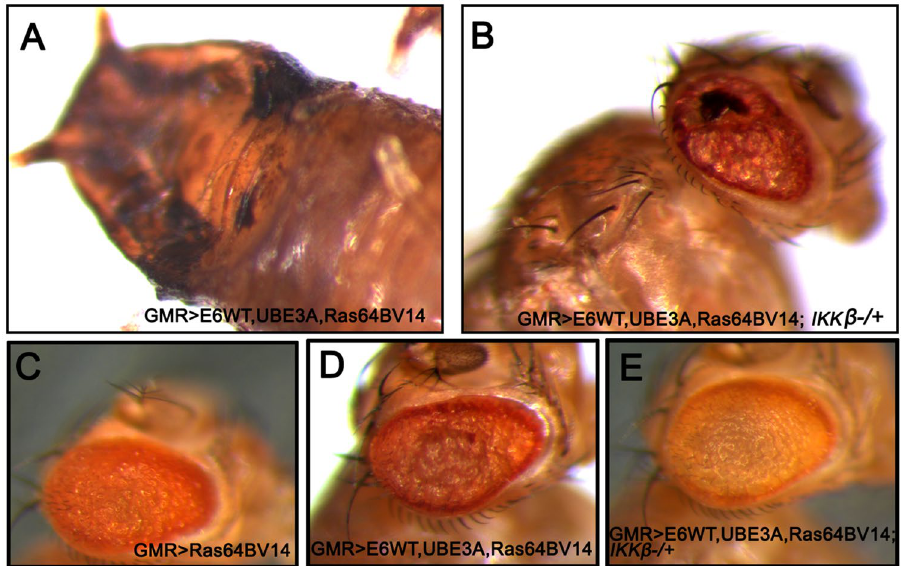
Figure 5. Reduction of IKKβ suppresses the cellular transformation caused by cooperative action of Ras and E6 + UBE3A. ( A , B ) Expression of transgenes at 25 °C. ( B ) A mutated copy of IKKβ gene in eyes expressing E6, UBE3A and an oncogenic Ras, suppresses pupal lethality and the severe defects caused by cooperative action of E6, UBE3A and oncogenic Ras ( A ). ( C – E ) Expression of transgenes at 22 °C. ( C ) Expression of oncogenic Ras in the eye causes cellular transformation. ( D ) Co-expression of E6 and UBE3A with oncogenic Ras enhances the Ras phenotype. ( E ) A mutated copy of IKKβ gene suppresses the severe eye abnormalities mediated by the synergistic effect of oncogenic Ras, E6 and UBE3A. Results shown are representative of those of 5 different